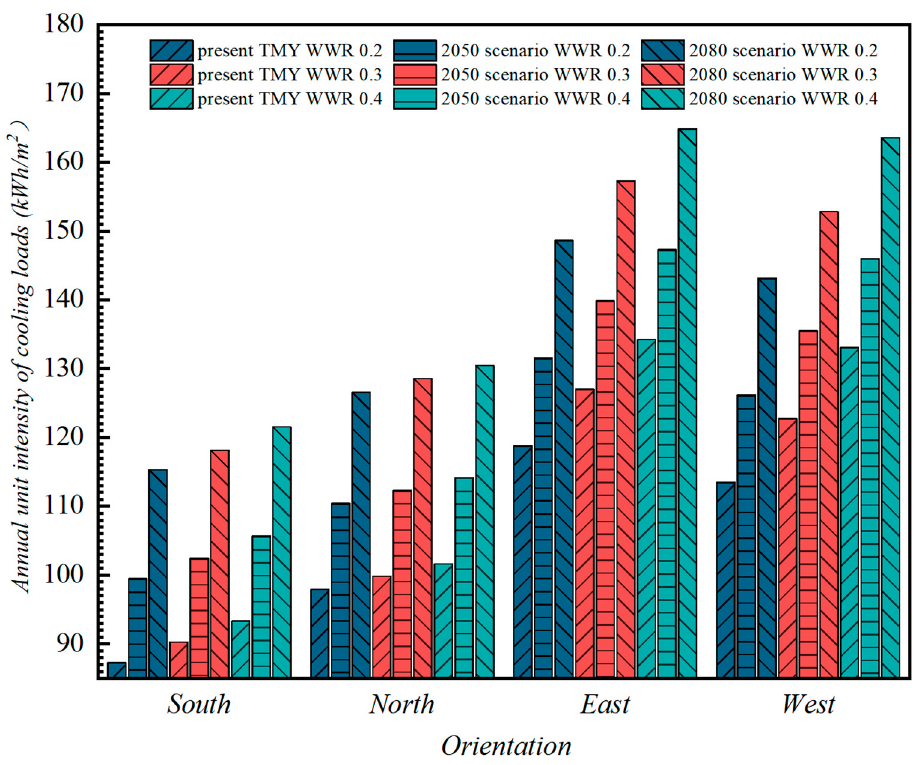
Figure 16. Annual unit intensity of cooling loads due to various wall orientations coupled WWRs of present TMY and predicted future scenarios (2050 and 2080).